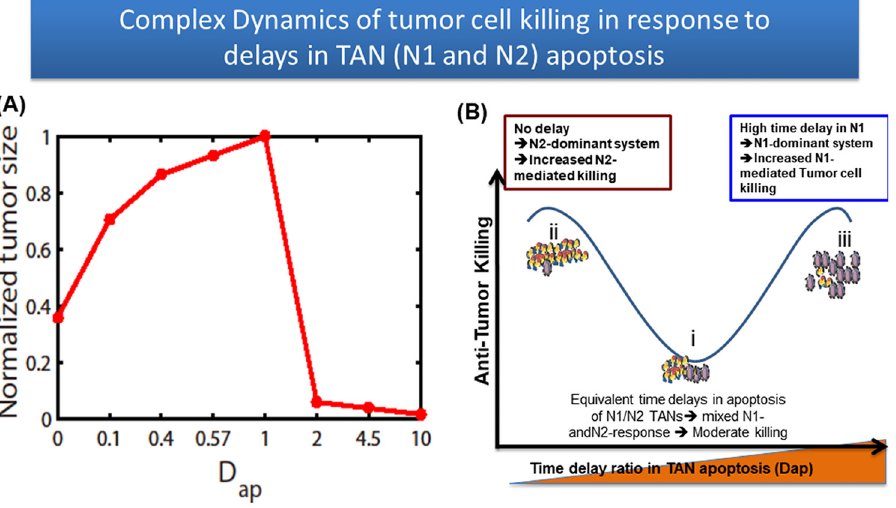
Fig 19. Effect of apoptosis delays of TANs in anti-tumor efficacy. (A) Tumor volume for various time delay ratios of TAN apoptosis ( D ap ). (B) A model depicting the impact of D ap on anti-tumor efficacy.